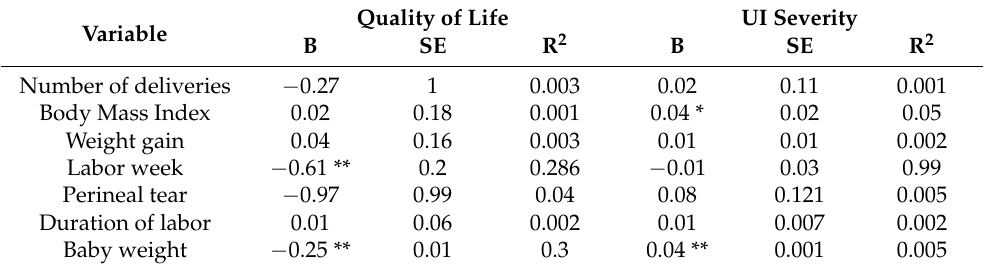
Table 3. Linear regression models of impact of urinary incontinence on quality of life and severity of urinary incontinence in relation to obstetrics variables (continuous variables) adjusted by